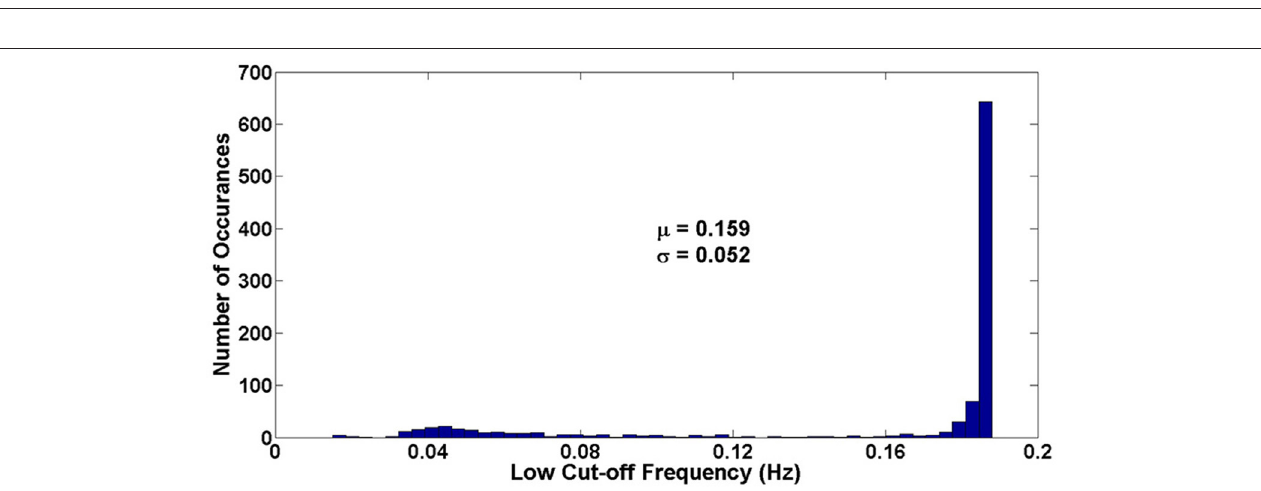
FIGURE 13 | Simulation of frequency response of neural amplifier with thick-oxide and standard PMOS differential pair.